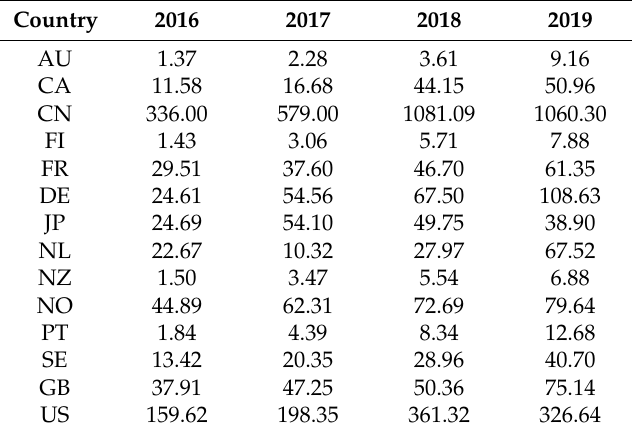
Table 2. Actual values of electric car sales (ECS).